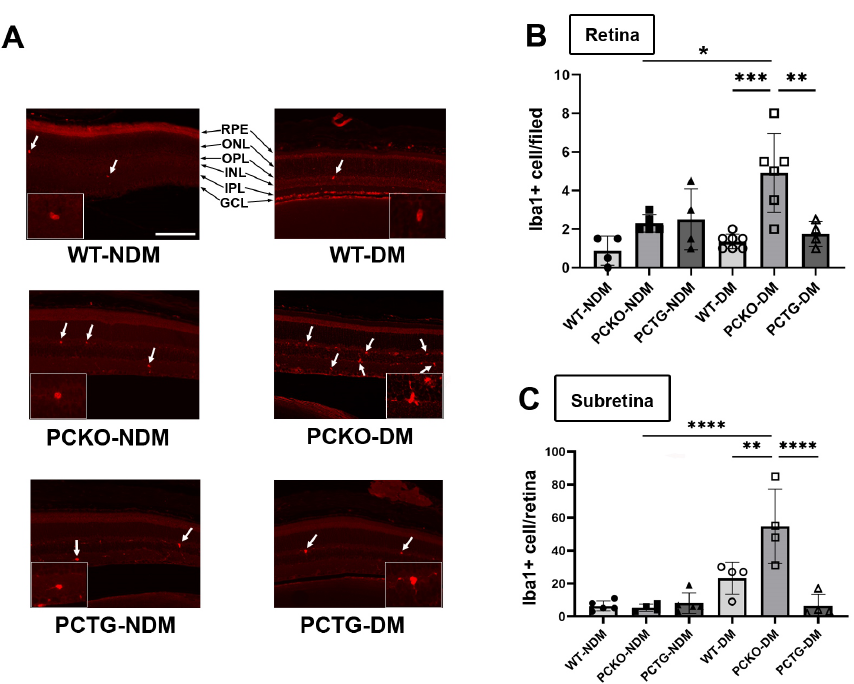
Figure 3. Increased microglial density in diabetic PCKO mice. ( A ) Representative immunostaining images with Iba1 + microglia (arrows) in retina sections. Scale bar: 100 µ m. ( B ) Quantification of retinal microglia density. n = 4–7 mice. ( C ) Subretinal microglial density on RPE/Choroid flat mounts, n = 4–7 mice. One-way ANOVA with Tukey’s posthoc comparison. Data are presented as mean ± SD. * p < 0.05, ** p < 0.01, *** p < 0.001, **** p < 0.0001. Abbreviations: IPL: inner plexiform layer, INL: inner nuclear layer; OPL: outer plexiform layer, ONL: outer nuclear layer; GCL: ganglion cell layer; RPE: retinal pigment epithelium, DM: diabetes mellitus, NDM: non-diabetes, WT: wild-type, PCKO: Microglial Ppar α conditional knockout, PCTG: Microglial Ppar α conditional transgenic